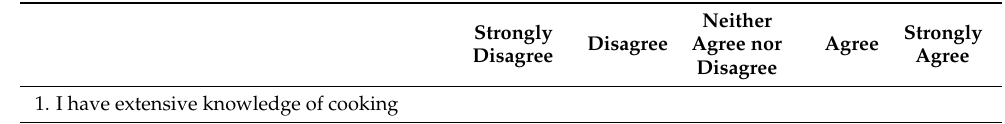
Table A1. Participant Background Questionnaire.